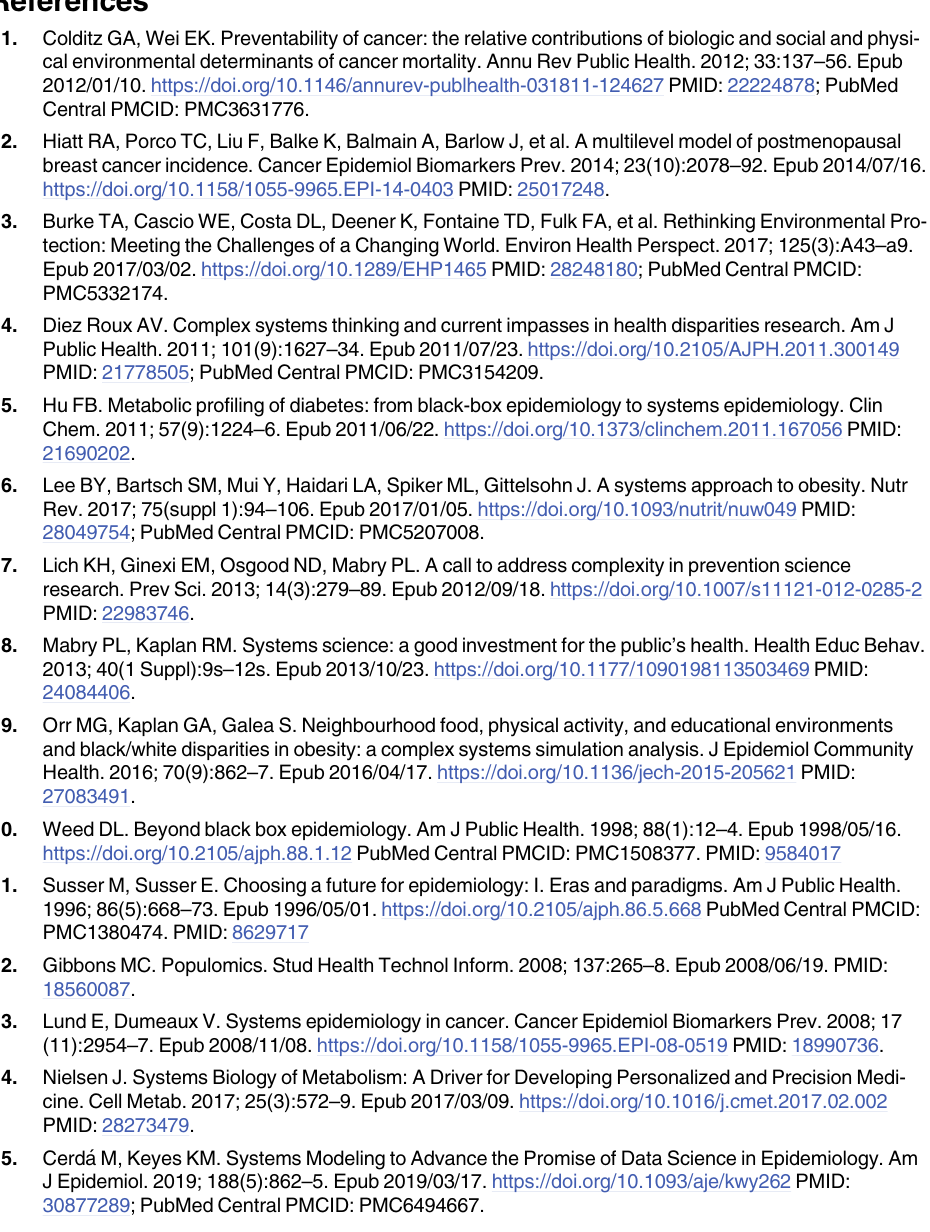
S1 Table. Expertise of workshop participants. S2 Table. Example methods applicable for systems epidemiology. S3 Table. Example data resources applicable for systems